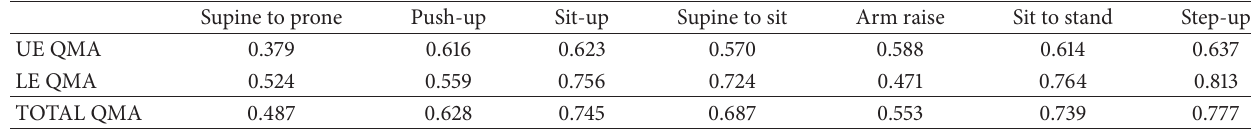
Table 4: Spearman’s correlation coefficients of the scaled QMA strength values and AMAT Functional subscale items. Supine to